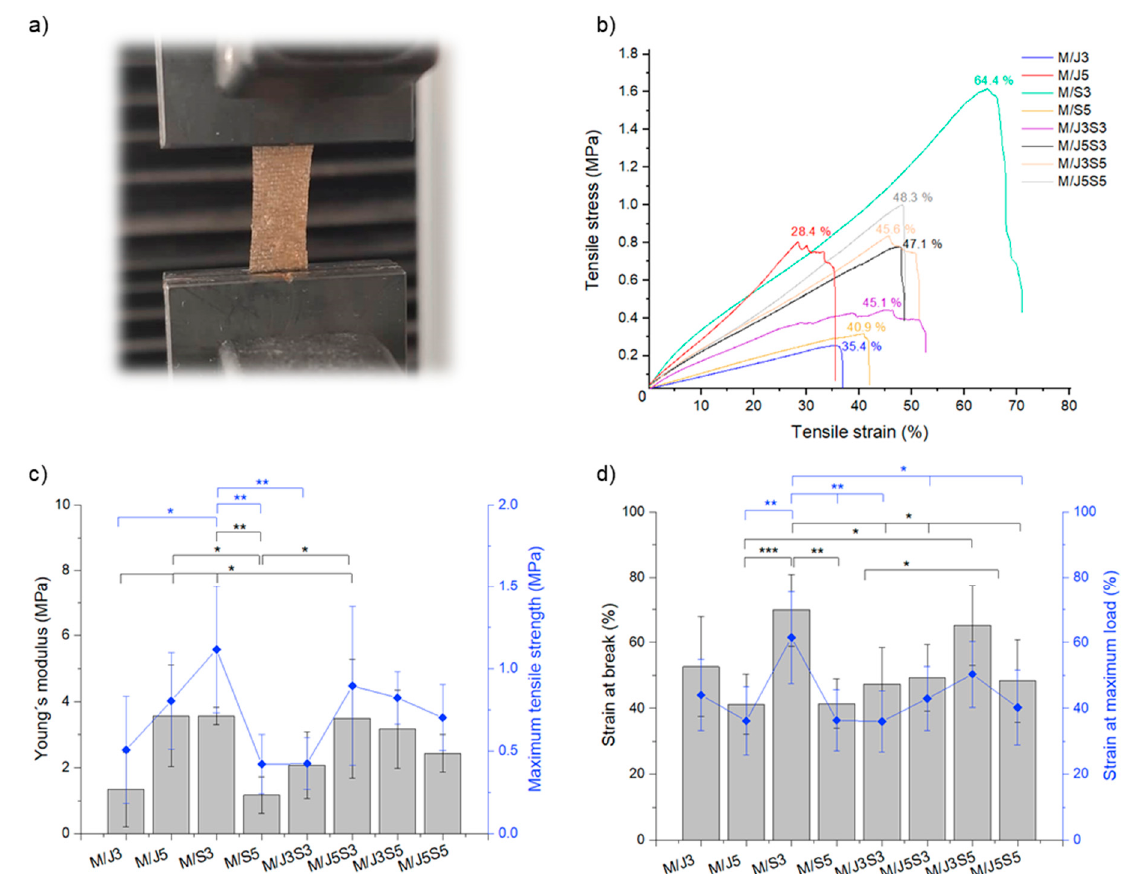
Figure 11. The mechanical properties of the marine biopolymers membranes (M/J3 to M/J5S5) addressed using uniaxial tensile testing. ( a ) Digital image of one condition (membrane M/J3) attached to Instron claws under load (representative of all samples); ( b ) Tensile stress–strain curves; ( c ) Young ´ s modulus and maximum tensile strength, and ( d ) strain at break and strain at maximum load. In graphics of ( c,d ), the error bars contain standard deviation (SD) from the mean values (not less than n = 5) and the symbols represent the statistical signi fi cance of * ( p < 0.05), ** ( p < 0.01), *** ( p < 0.001) using one-way ANOVA with Tukey´s multiple comparisons test.